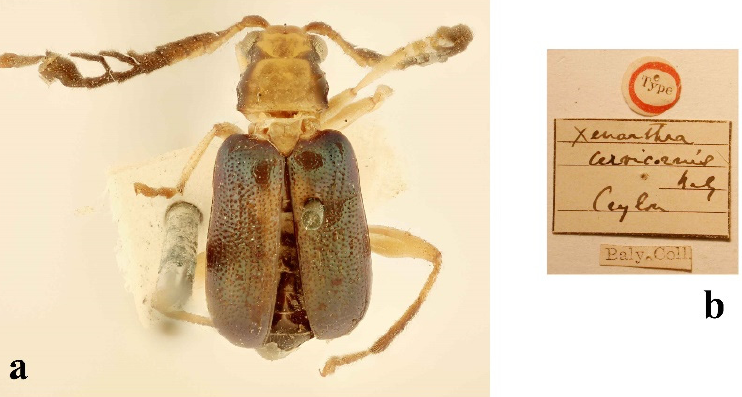
Figure 1. Taumacera cervicornis (Baly, 1861): ( a ) syntype, male; ( b ) labels. (Not to scale).